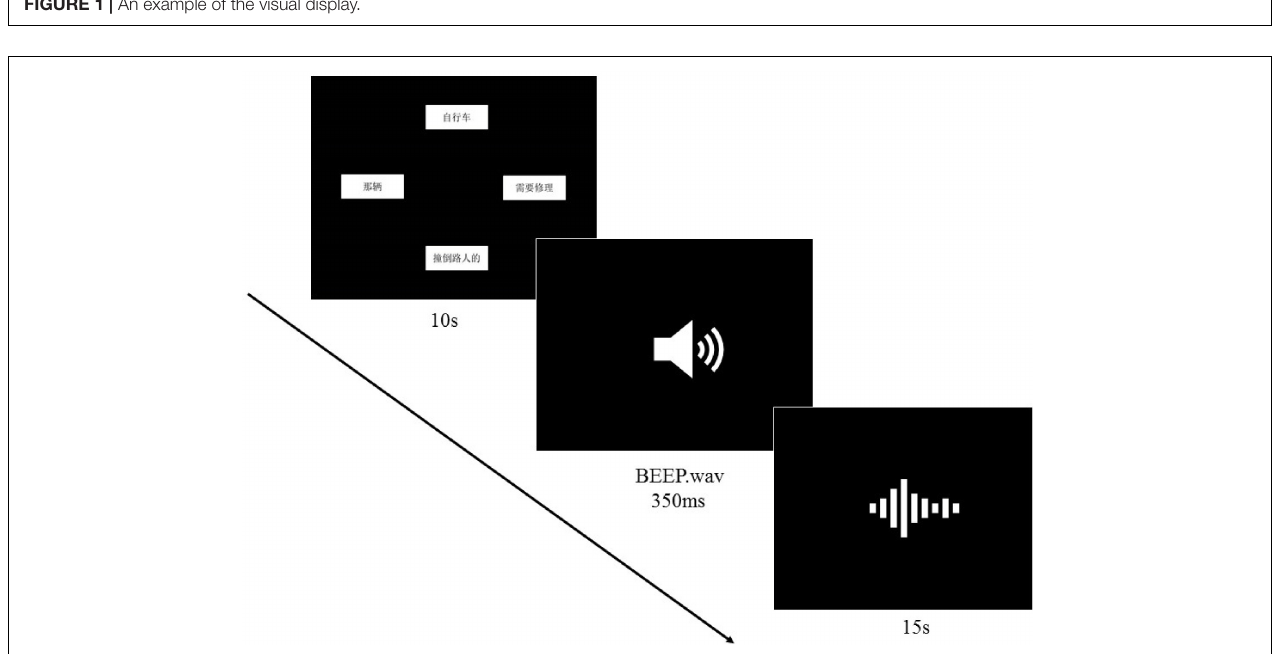
FIGURE 2 | Experimental procedure for L2-Chinese